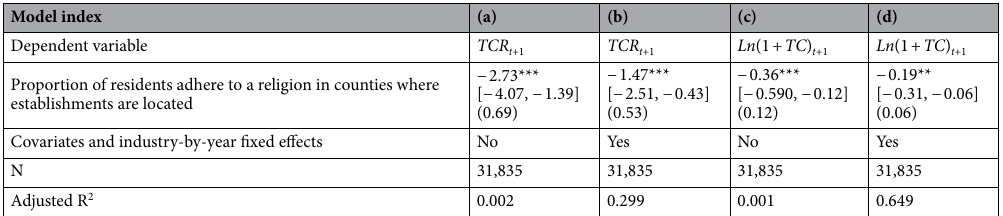
Table 1. The relationship between the degree of county religious affiliation and measures of workplace injury. Columns (a) and (b) display statistics from models that regressed each private-sector establishment’s Total Case Rate of injuries, illnesses, and deaths (TCR)—as recorded by the United States Occupational Safety and Health Administration (OSHA) 40 from 2002 to 2011—on, respectively, its county’s proportion of residents acknowledging a religious adherence 30,33,34 (a) and that variable plus a set of covariates and industry-by-year fixed effects (b). Columns (c) and (d) report regressions of the natural logarithm of one plus Total Cases of injuries, illnesses, and deaths (TC) 40 on those same variables. All coefficient estimates and associated statistics appear in the supplementary information, but we display the estimate for the focal coefficient—proportion of population adhere to a religion in the county where an establishment is located—in the third row of the table, following the model index and the listing of the dependent variable used in each model. The fourth row indicates whether the model involved covariates and binary indicators signaling the industry-year of a given record for an establishment. The second to last row lists the number of observations (N) and the final row displays the proportion of explained variance (R 2 ), adjusted for covariates. Asterisks denote the level of